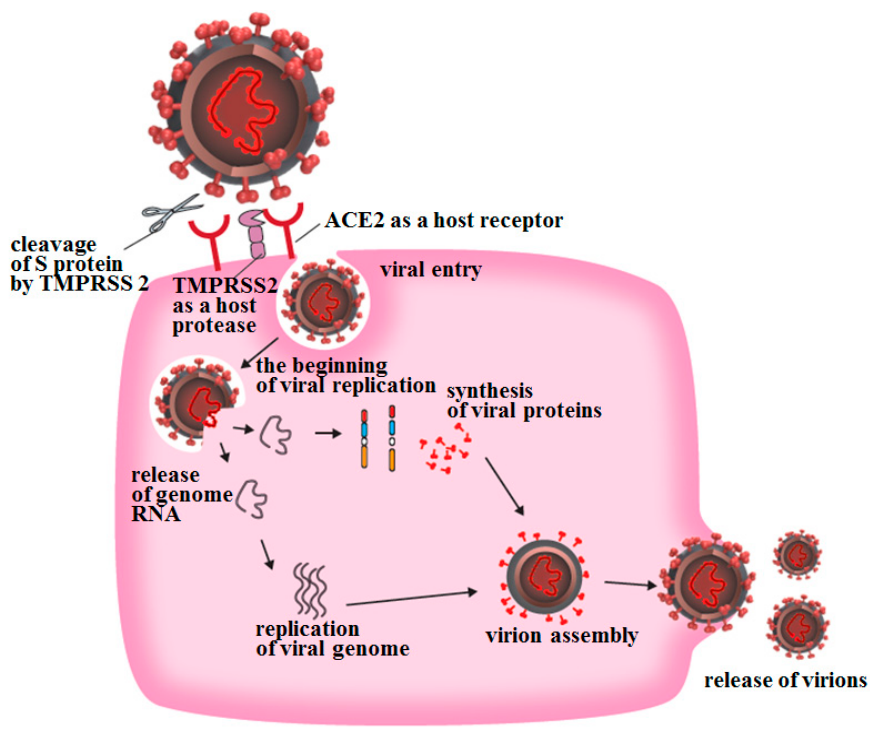
Figure 2. Adsorption and entry of SARS-CoV-2 into host cells. SARS-CoV-2 begins to invade target cells when the viral S protein expressed on the envelope binds to the ACE2 receptor, which is often expressed on the cytoplasmic membrane of target cells.